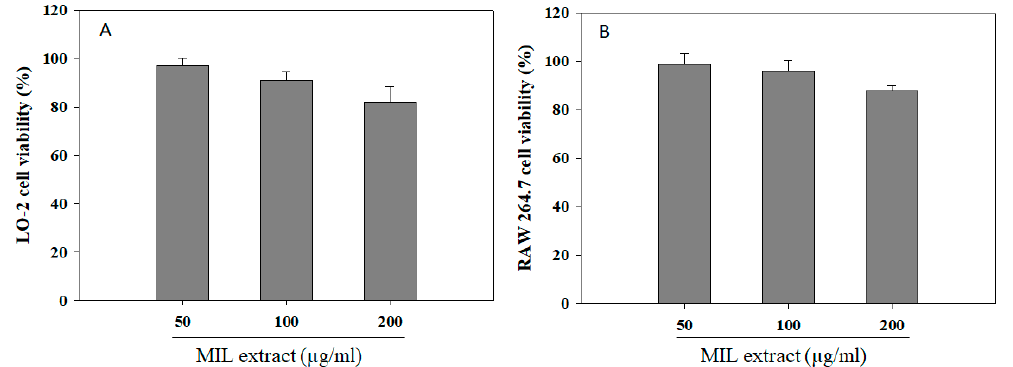
Figure 6. Cell viability of M. indica leaves (MIL) extract on hepatic LO-2 cells ( A ) and RAW 264.7 macrophage cells ( B ). The cells were incubated with the extract for 24 h. Cell viability was assessed by MTT method, and the results were expressed as percentage of surviving cells over blank cells. Each determination was made in three independent experiments, and the data are shown as means ± SD.